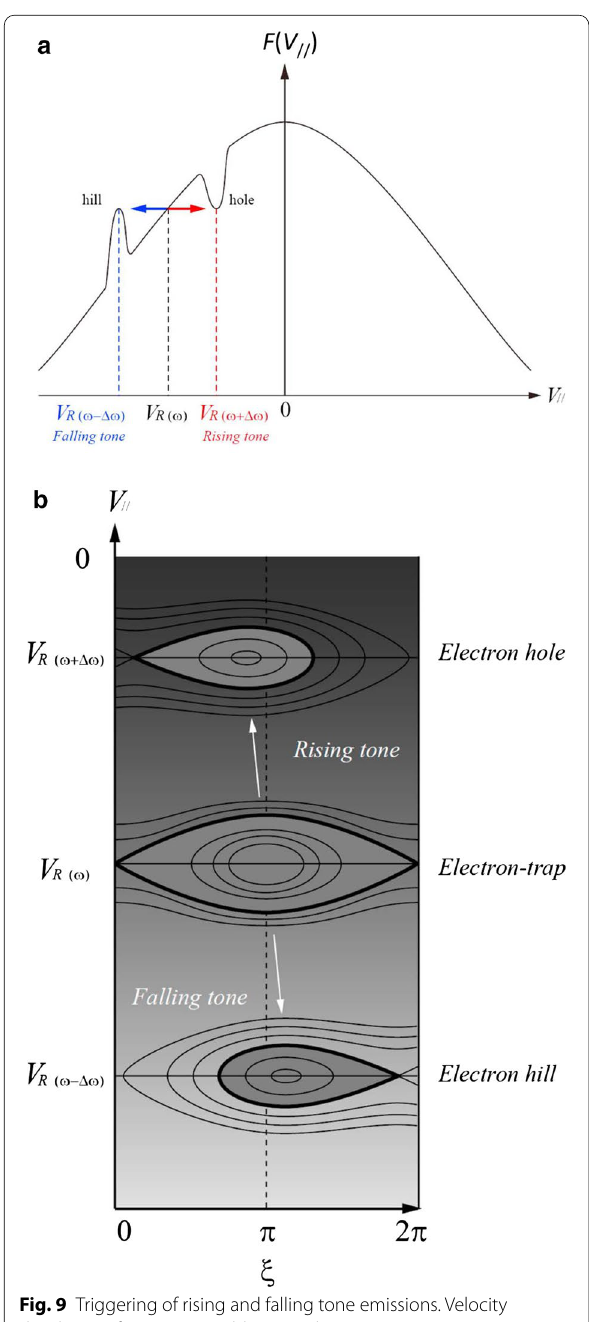
Fig. 9 Triggering of rising and falling tone emissions. Velocity distribution function unstable to a coherent triggering wave. a Variation of resonance velocities of rising-tone and falling tone emissions. b Electron hole and hill in the velocity phase space giving growth to rising-tone and falling-tone emissions (after Omura et al.